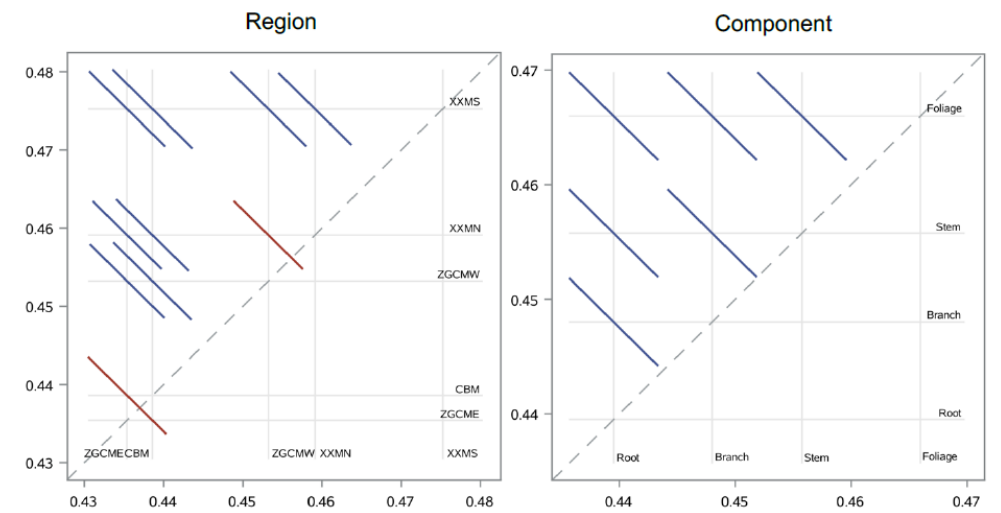
Figure 3. The diffograms (mean-mean scatter diagrams) of multiple comparisons of adjusted least squares means for the Mongolian oak tree components and growing regions. The diagonal reference line in each diffogram represents the line of unity for all pairs with equal least square means. The line segment that is forming a 90-degree angle to the line of unity represents a different series of treatment as indicated by grid labels, each centered by the pair’s least square means and its length proportional to the pairwise difference range of values. The line segment colors indicate the significant/insignificant difference between pairs: blue ( p ≤ 0.05); red (not significant).